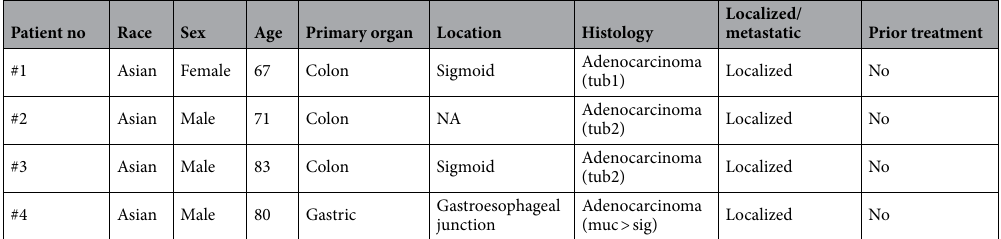
Table 1. Clinical characteristics of the tumors. tub1 tubular adenocarcinoma well differentiated type, tub2 tubular adenocarcinoma moderately differentiated type, sig signet-ring cell carcinoma, muc mucinous adenocarcinoma, NA not available.